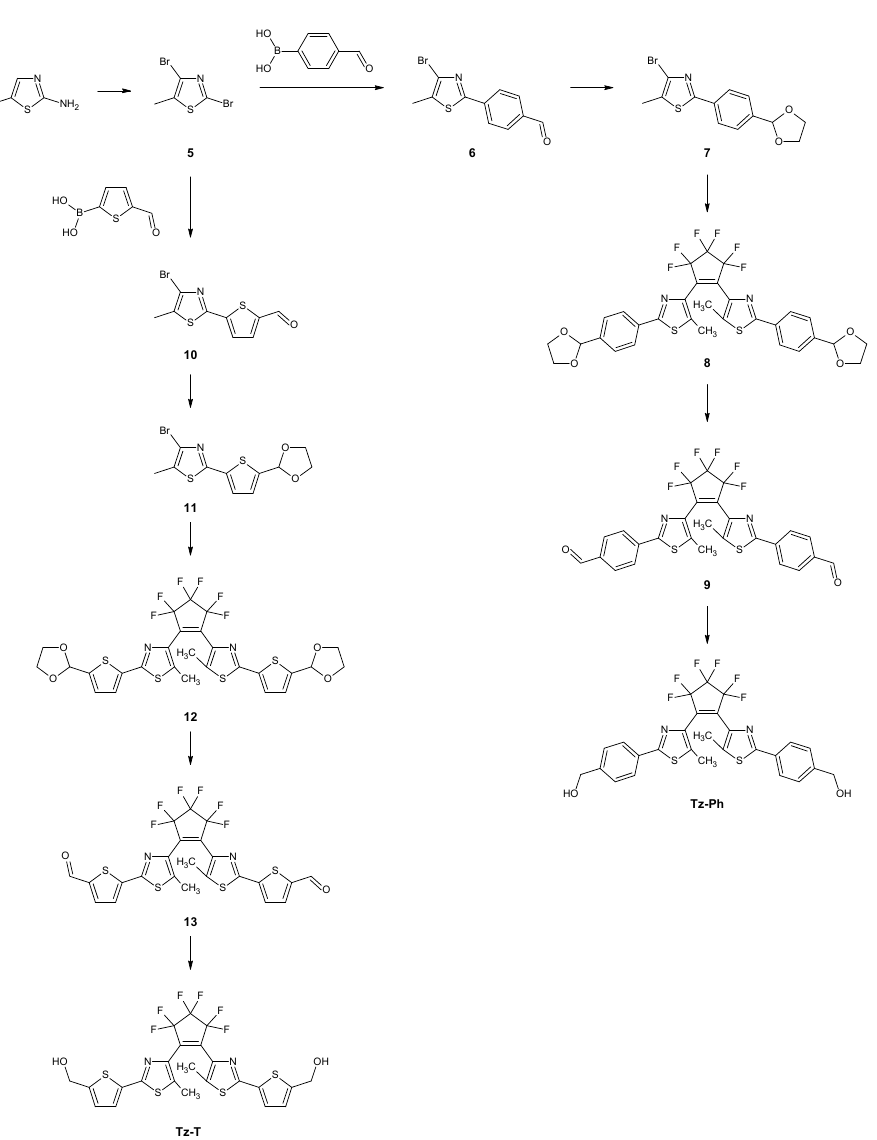
Scheme 2. Synthesis of the monomers Tz-T and Tz-Ph .